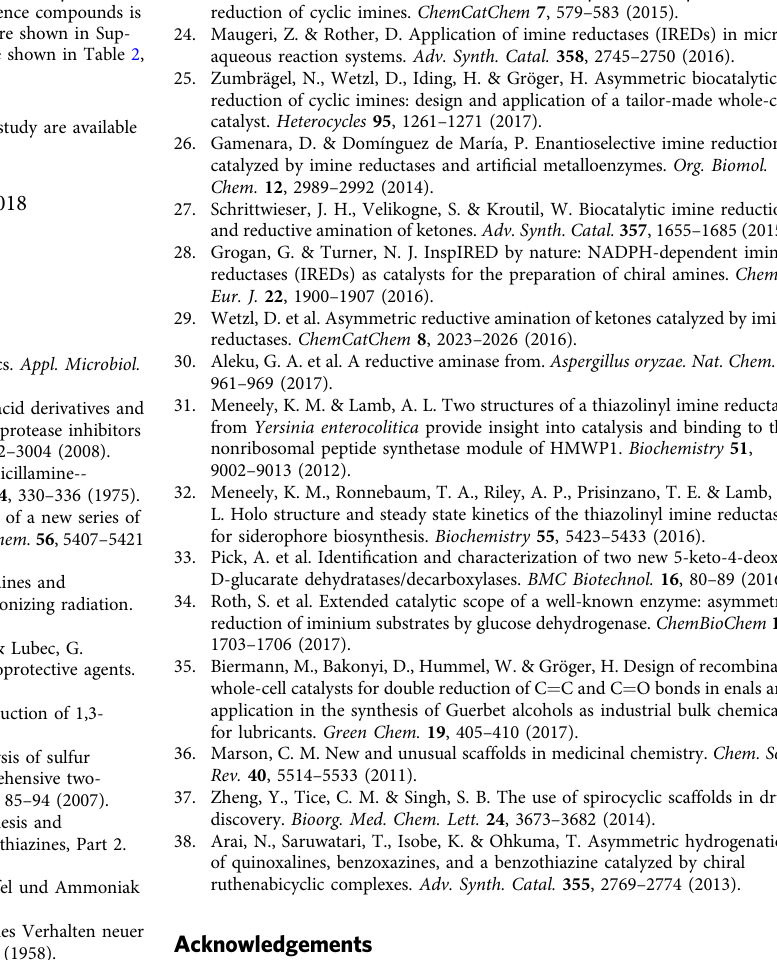
(Supplementary Figs. 93 – 95, Supplementary Table 7 and Supplementary Methods; synthesis of racemic 3-3,4-dihydro-2 H -1,4-benzothiazine reference compounds is described in Supplementary Methods and related NMR data are shown in Sup- plementary Figs. 96 – 101). The results of these experiments are shown in Table 2, details are provided in Supplementary